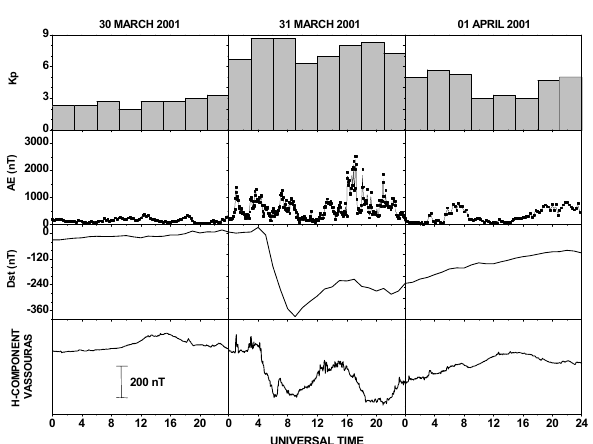
Figure 1 Fig. 1. Time variations of the K p , AE and D st geomagnetic indices for the period 30 March–1 April 2001. Also, the geomagnetic field H-component variations observed at Vassouras, Brazil are